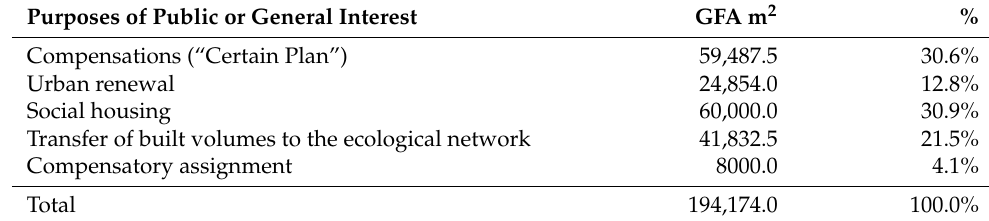
Table 8. Hypothesis of distribution of the public GFA.